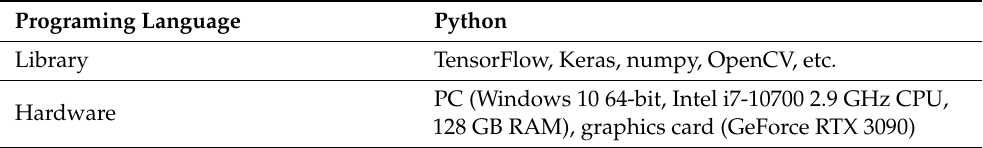
Table 5. Development